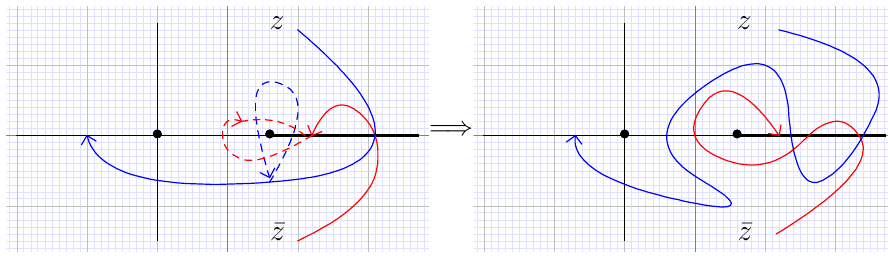
Figure 14 . Deforming the z, z curves for the hO 1 O 3 O 2 O 4 i